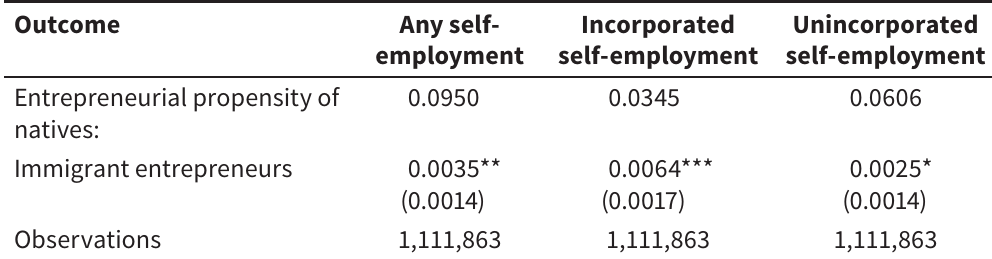
Impact of immigrant entrepreneurs on entrepreneurial propensities of natives: LPM Outcome Any self-